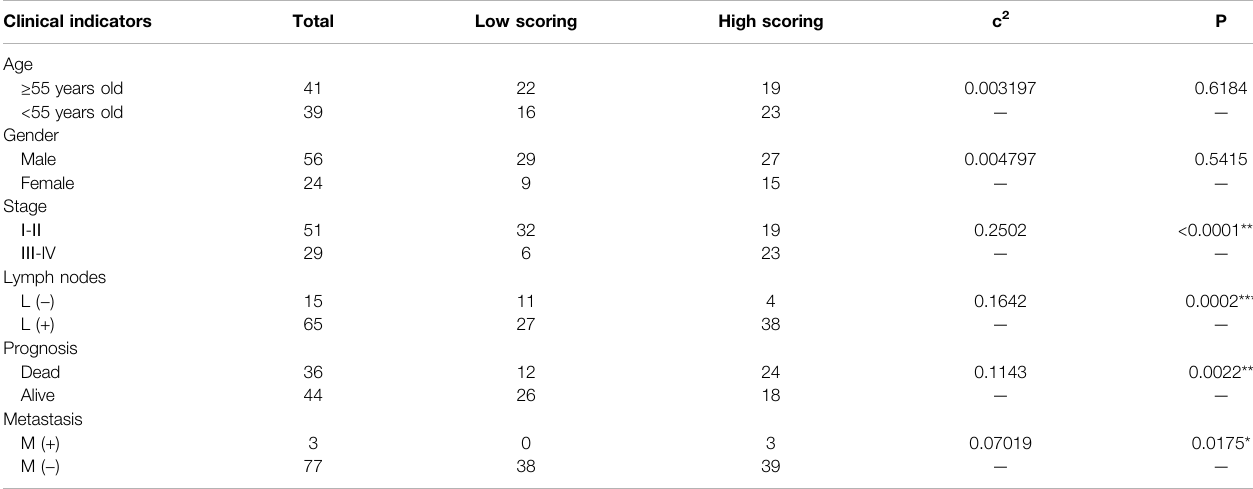
TABLE 1 | Relationship between MIF expression and clinical pathological factors of nasopharyngeal carcinoma. Clinical indicators Total Low scoring High